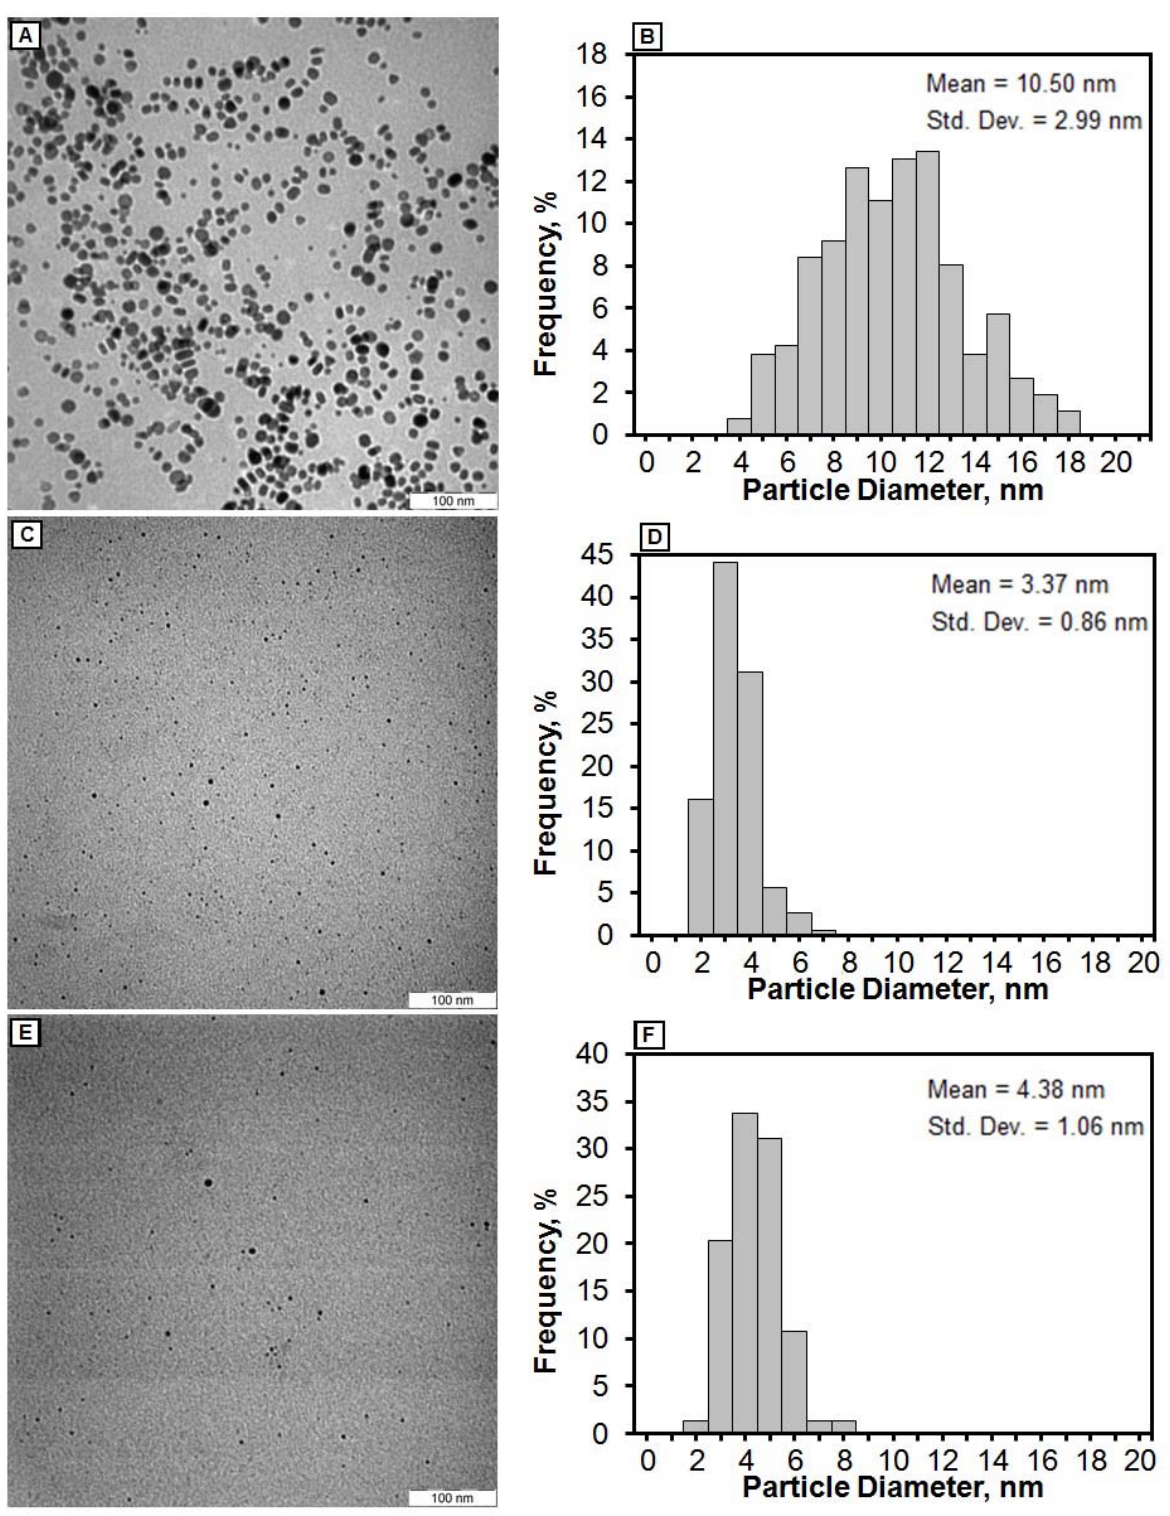
Figure 4. Transmission electron microscopy images and corresponding particle size distributions of Ag/Cts ( A , B ), Ag/Cts/gelatin ( C , D ) and Ag/gelatin ( E , F )